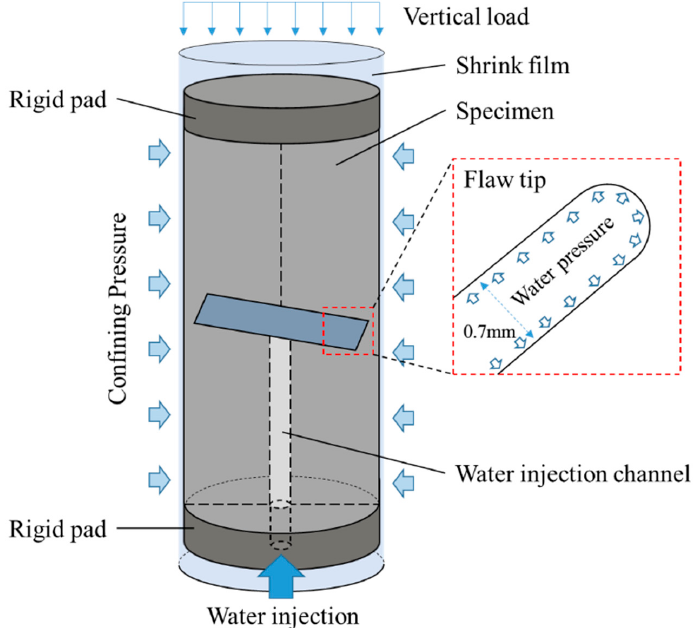
Figure 2. The loading condition of the hydraulic coupled triaxial test.